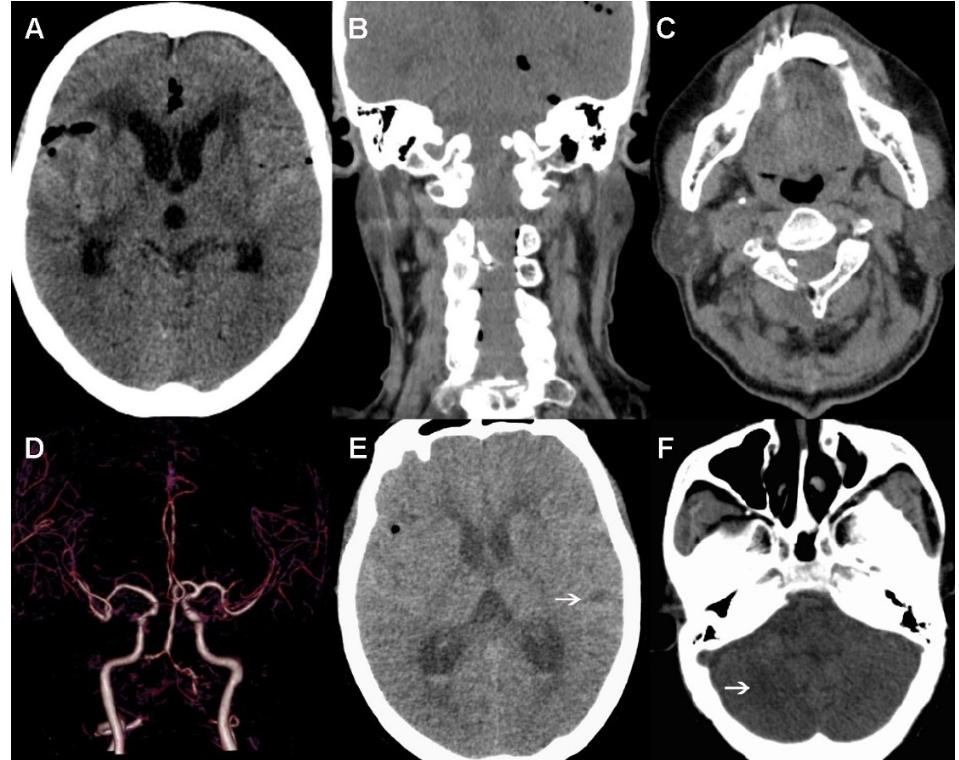
Figure 4. Postoperative images. ( A – C ) No cerebral hemorrhage or infarction is observed in the first day after surgery, and the clip is well positioned. ( D – F ) Cerebral vasospasm and cortical hypodense changes (indicated with arrows) found 3 days postoperative.